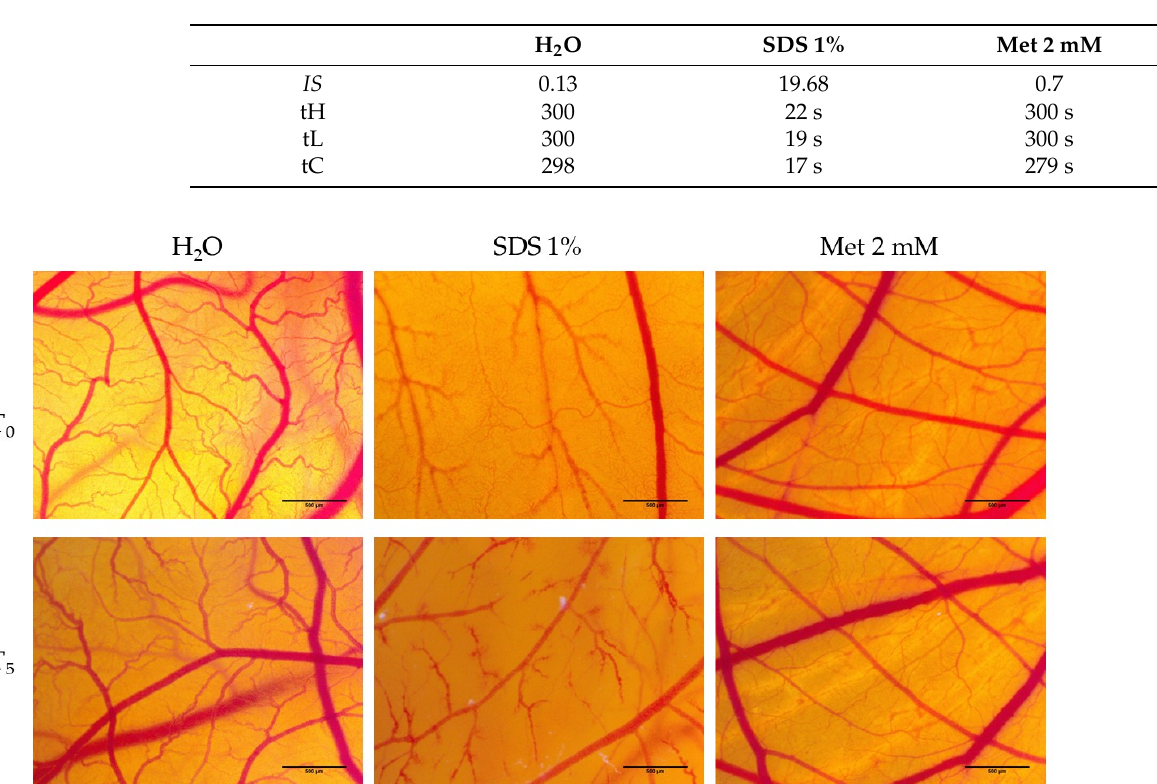
Table 1. Irritation score values for the positive control (SDS 1%), negative control (distilled water) and Met 2 mM.